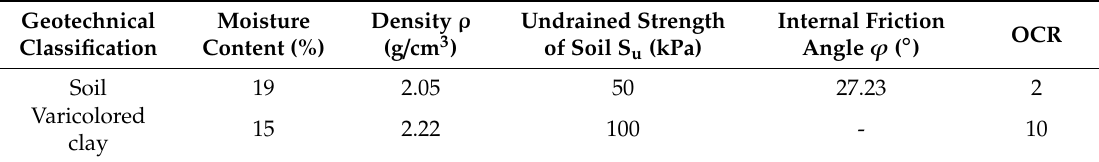
Table 1. Calculation parameters of geotechnical materials for the Masseria Marino